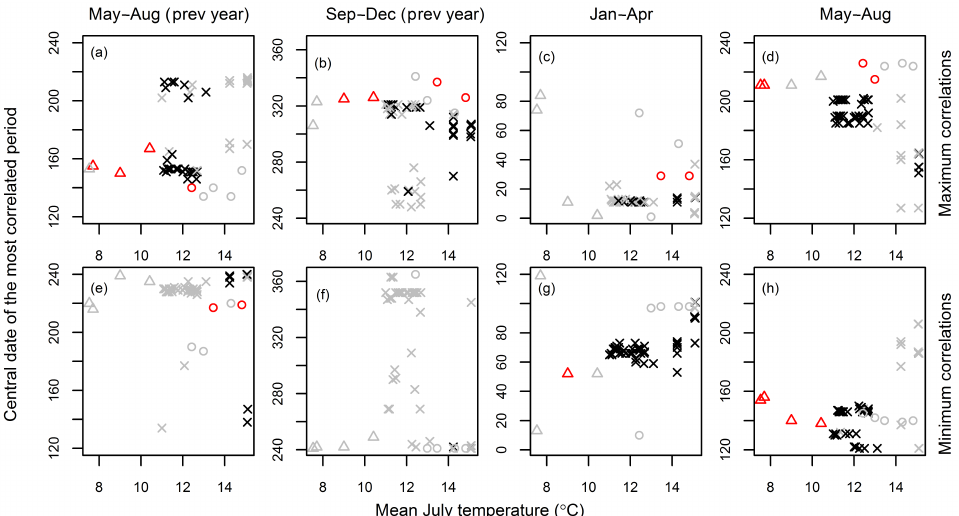
Figure 6. The central dates of the 31-day time windows with maximum (largest positive) (a–d) and minimum (largest negative) (e–h) correlations between the RWIs and temperature in Fig. 4. The black X mark denotes the plots in Finland and the plots on the south-central Tibetan Plateau (SCTP) are marked with red circles and on the southeastern Tibetan Plateau (SETP) with red triangles. The grey colour indicates correlations not significant at the 5%